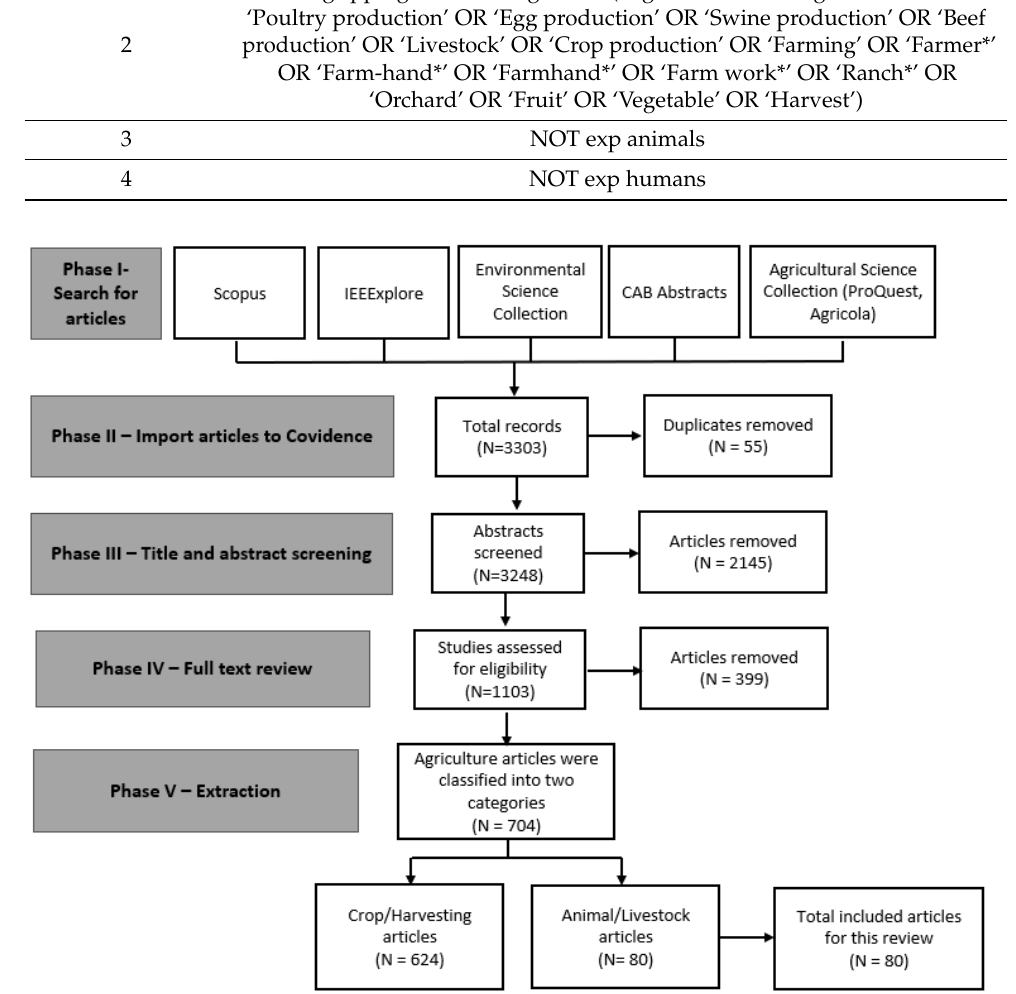
Figure 1. Flow chart of articles selection process.